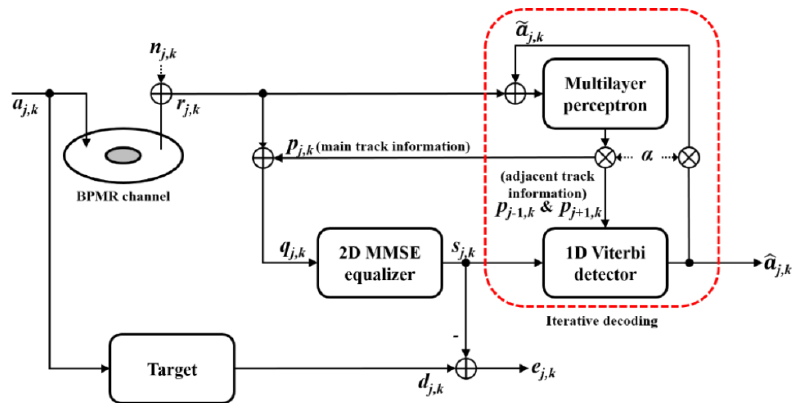
Figure 1. Block diagram of proposed bit-patterned media recording (BPMR) system model.